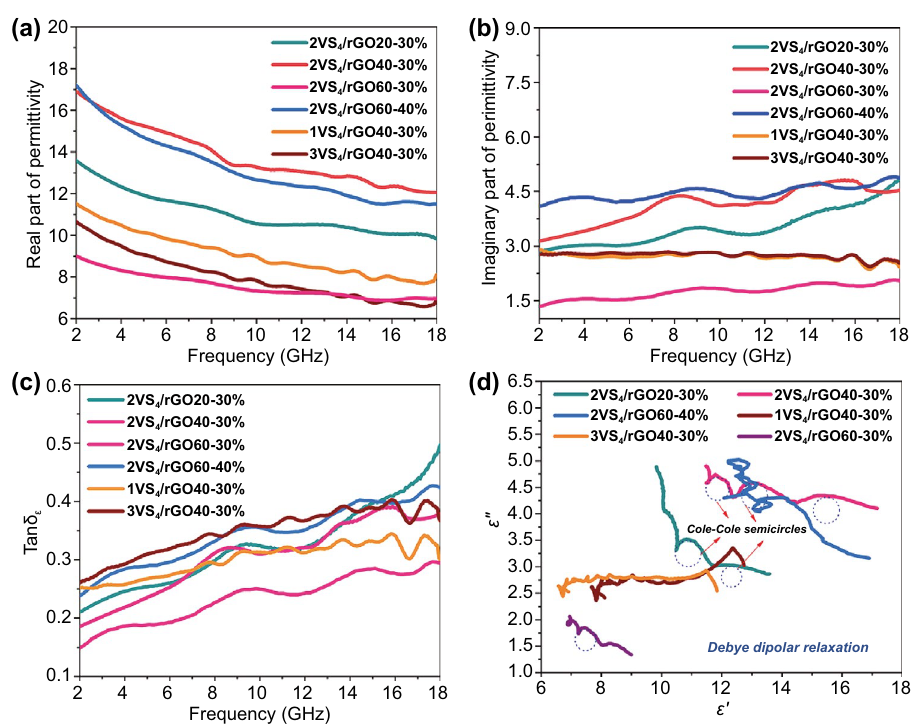
Fig. 4 Permittivity and dielectric loss tangent of VS 4 /rGO heterostructures in the frequency range of 2–18 GHz: a ε ′ , b ε", c Tan δ ε . d Cole– Cole semicircles for VS 4 /rGO